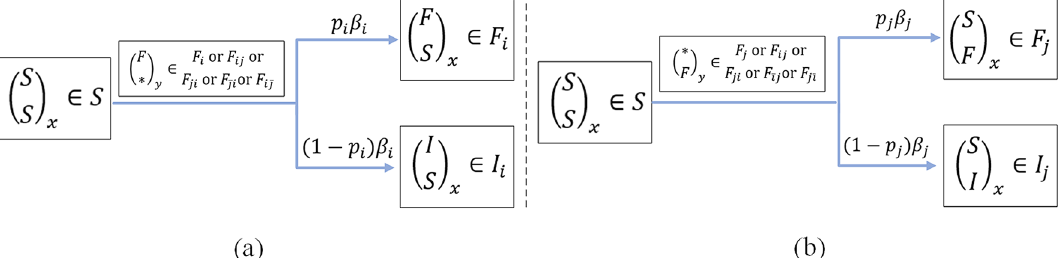
Figure 4. Transmission dynamics of one single information: ( a ) information i ; ( b ) information j